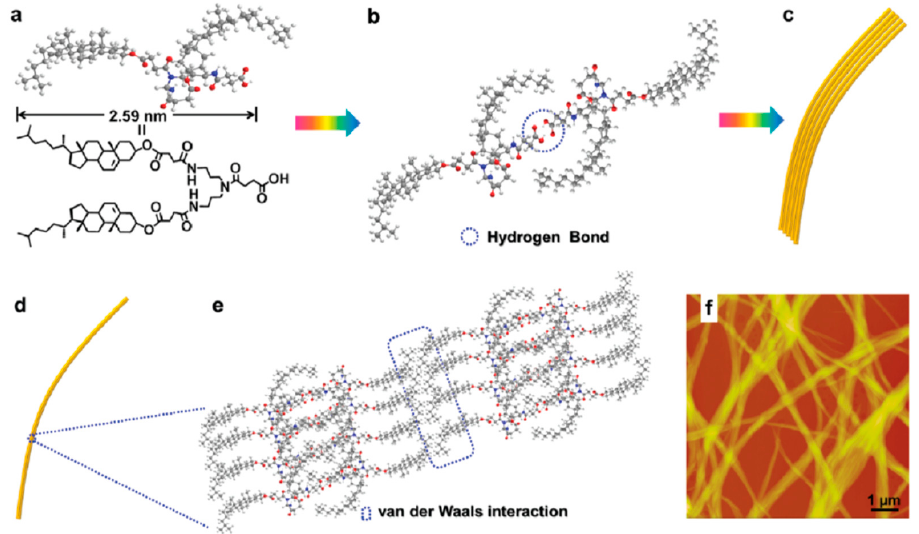
Figure 24. ( a ) Molecular structure of compound 34 ; ( b ) molecular structure of the dimer of 34 ; ( c ) fibers; ( d ) single nanofiber; ( e ) probable molecular packing model of 34 in a fiber and ( f ) the AFM image of the xerogel obtained from 34 in toluene ( cgc = 10 mL − 1 ). Reprinted with permission from CNRS and RSC [57].